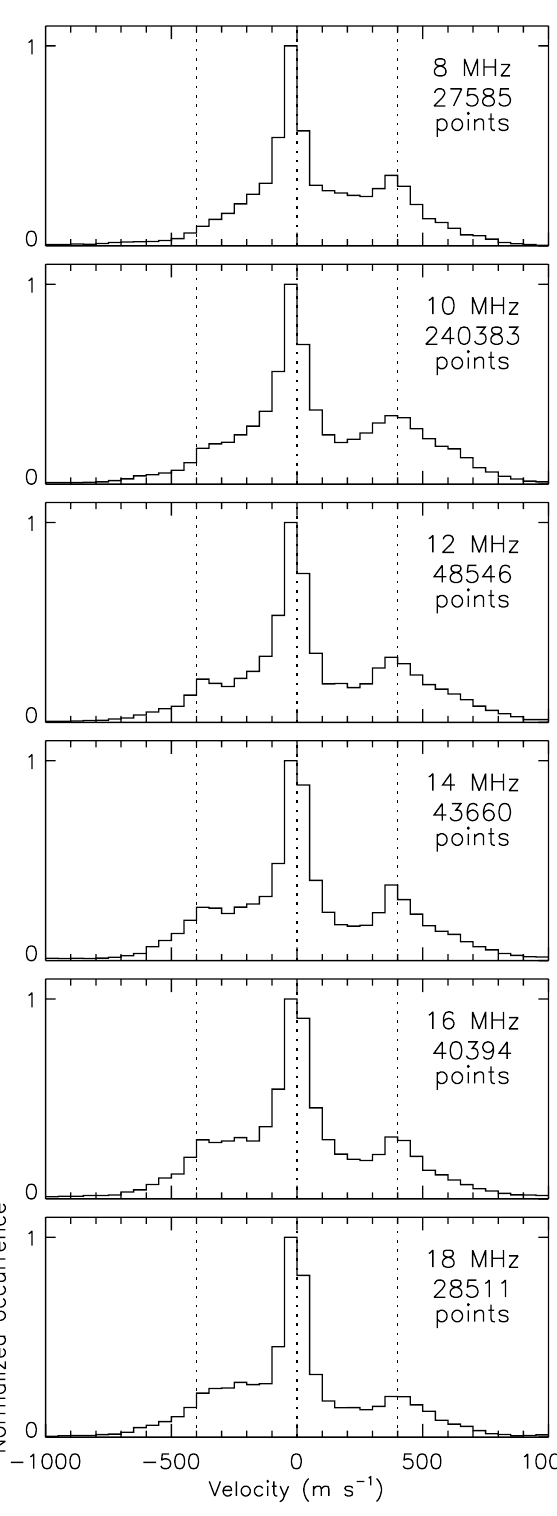
Fig. 4. Occurrence distributions of Doppler shift observed in the six frequency bands. Vertical dotted lines at ± 400ms − 1 approxi- mately indicate the ion-acoustic